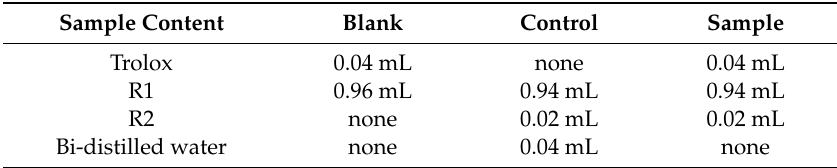
Table 5. Sample composition for the trolox ABTS • +